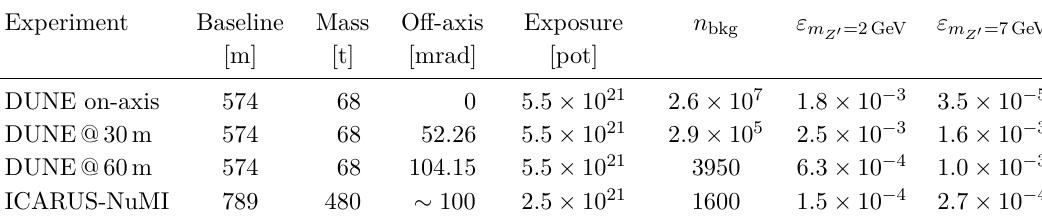
Table 1 . Summary of experimental setups considered for leptophobic DM. We have used a primary proton energy of 120 GeV and the expected exposure after 5 years for both DUNE and ICARUS- NuMI. A cut on the visible energy ( E 3 GeV ) is applied to all signal and background events, vis > with n being the number of background events that pass the cut. The two rightmost columns bkg indicate the geometric acceptance at two different Z 0